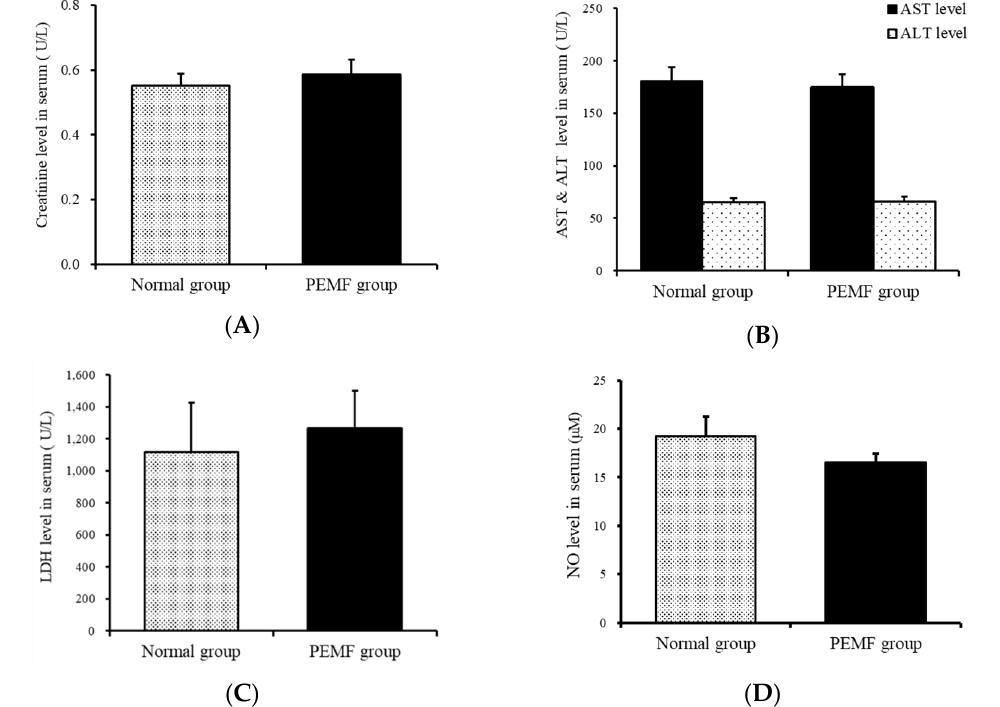
Figure 8. Effect of PEMF treatment on creatinine, AST, ALT, LDH, and NO levels in the serum. ( A ) Creatinine, ( B ) AST and ALT, ( C ) LDH, and ( D ) NO levels. Effects of PEMF treatment on kidney and liver function, circulating cell damage, and inhibiting inflammation were evaluated by ELISA and biochemical analysis.